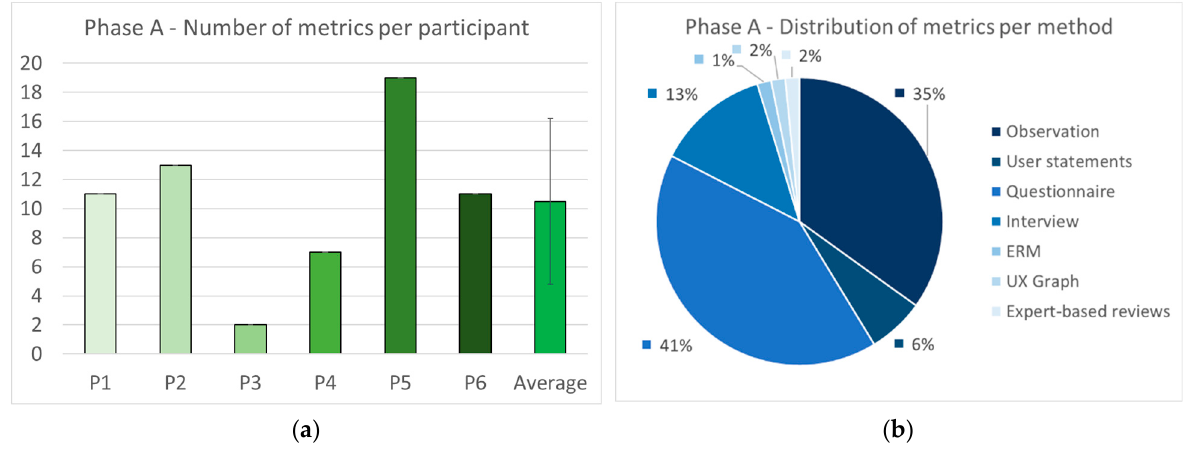
Figure 7. Phase A metrics: ( a ) number of metrics per participant ( b ) distribution of metrics per method Table 5. Number of metrics proposed per method in phase A.